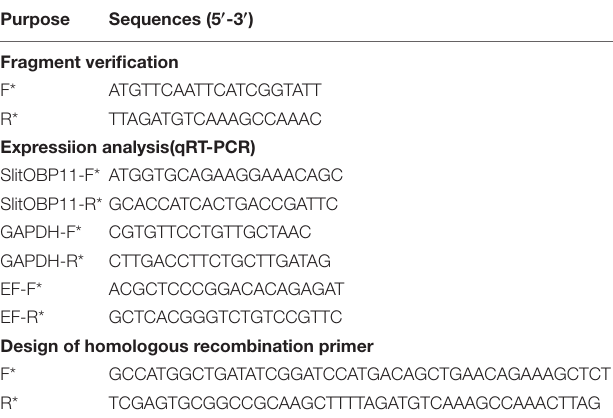
TABLE 2 | Binding affinities of SlitOBP11 for plant volatile compounds and female sex pheromones of S. litura